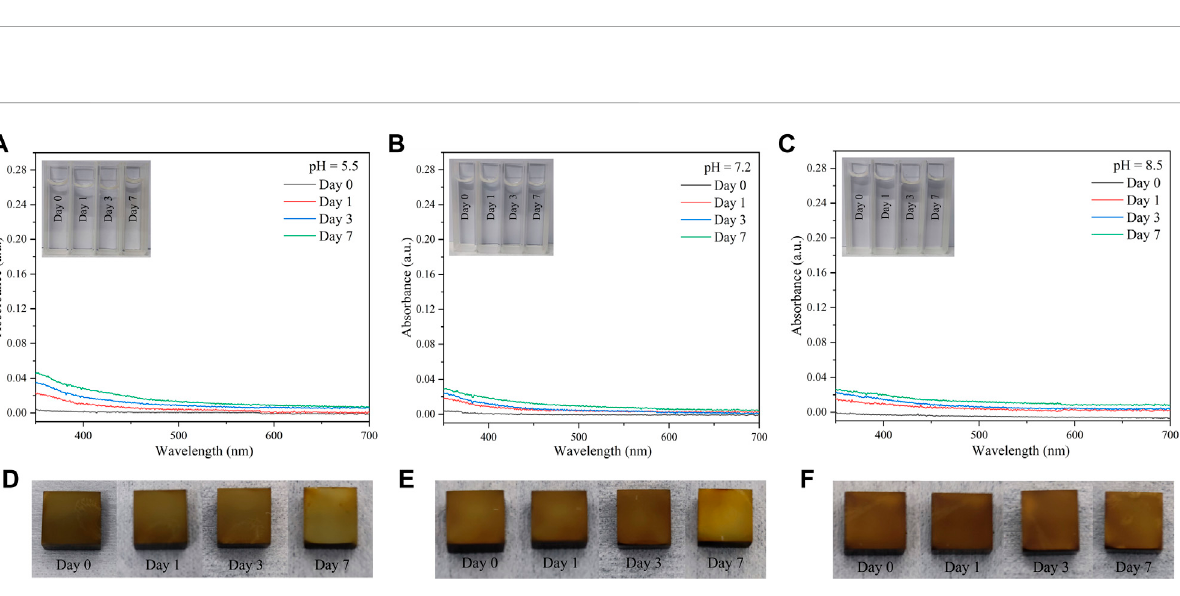
FIGURE 3 (A) Water contact angles of the pTi, Ti-PDA, Ti-P(DA-co-SBMA), Ti-Cu@PDA and Ti-Cu@P(DA-co-SBMA). (B) XPS spectra of the Ti-PDA, Ti-P(DA- co-SBMA),Ti-Cu@PDAandTi-Cu@P(DA-co-SBMA). (C) High-resolutionCu2pspectraoftheTi-PDA,Ti-P(DA-co-SBMA),Ti-Cu@PDAandTi-Cu@P(DA- co-SBMA). (D) SEM images of the pTi, Ti-PDA, Ti-P(DA-co-SBMA), Ti-Cu@PDA and Ti-Cu@P(DA-co-SBMA). Scale bar: 2 μ m. (E) AFM images of the pTi, Ti-PDA, Ti-P(DA-co-SBMA), Ti-Cu@PDA and Ti-Cu@P(DA-co-SBMA). Scale bar: 2 μ m.